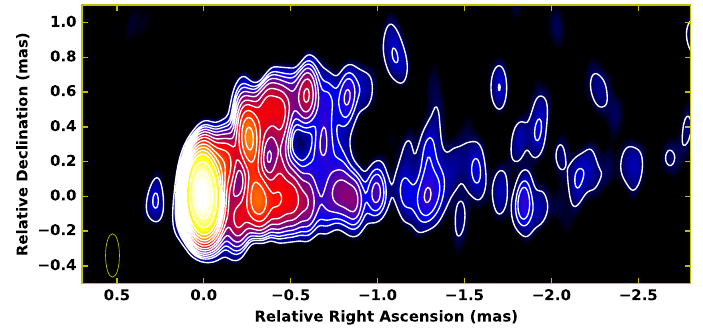
Figure 1. VLBA+GBT 86GHz image of M87 jet [24].